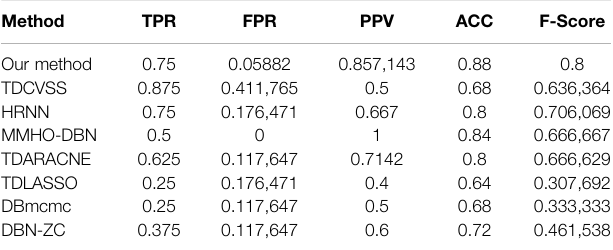
TABLE2| Performancecomparison ofeightmethodsforIRMAnetworkinference with the on dataset.